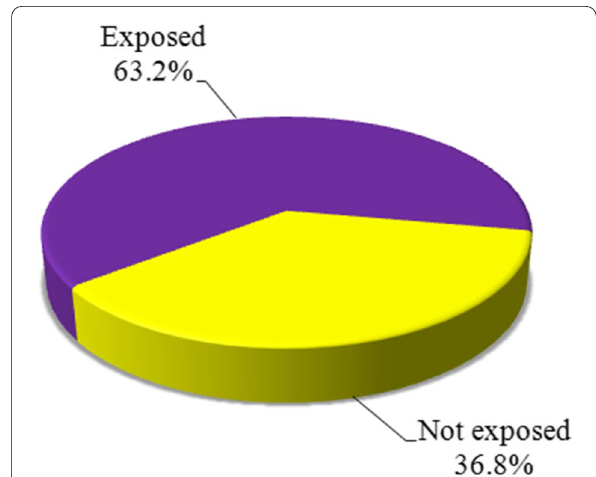
Fig. 1 The prevalence of workplace violence exposure among the studied healthcare workers in context with the COVID‑19 pandemic in Egypt ( n 405) =